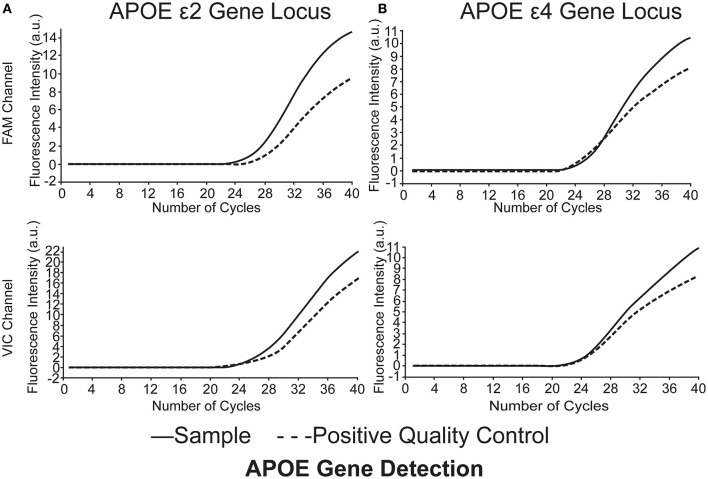
APOE genotype of the subjects was identified as ε2/ε4. (A)
APOEε2 gene locus FAM channel (+) VIC channel (+), (B)
APOEε4 gene locus FAM channel (+) VIC channel (+). Polymerase chain reaction multiple fluorescence quantitative determination (QF-PCR) was utilized in the present study.